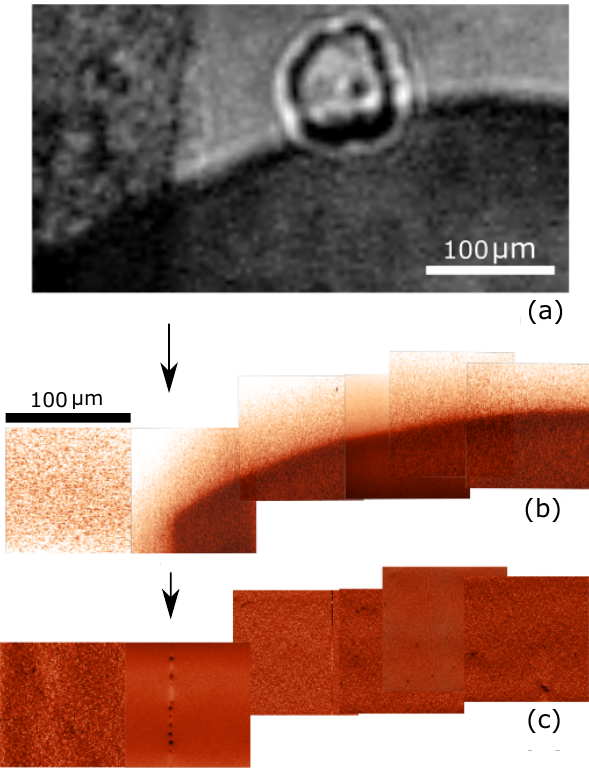
Figure 6. Images of the same region of a z -oriented Cr 2 O 3 sample showing the spatial distribution of ( a ) SHG; ( b ) magnetoelectric signal; ( c ) topography. The arrows mark a scratch on the sample